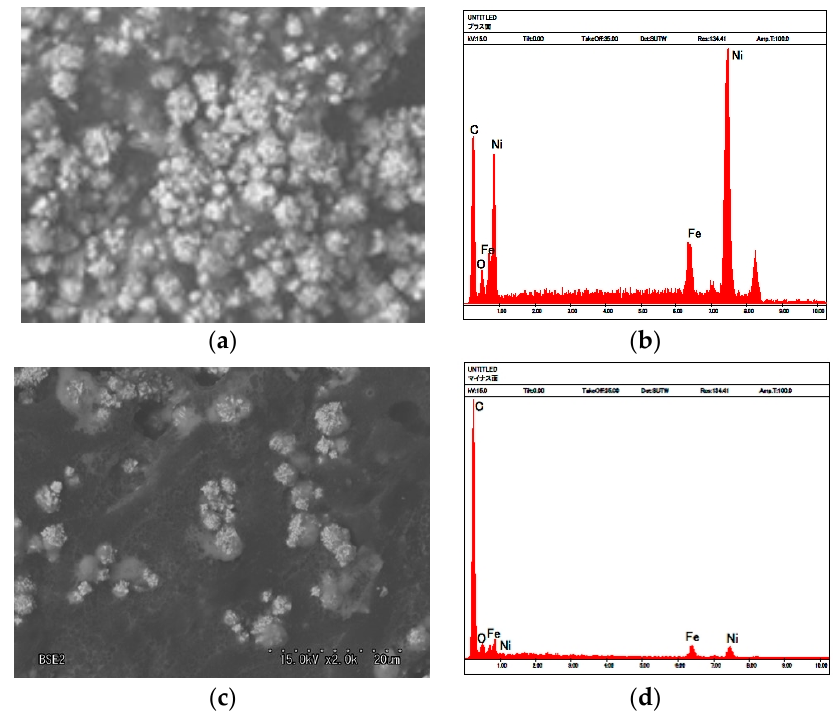
Figure 10. Photographs of ( a ) anode-side and ( c ) cathode-side surfaces of solidified MCF rubber by SEM (2000× magnification); ( b ) XRD mapping on ( a ); ( d ) XRD mapping on ( c ).